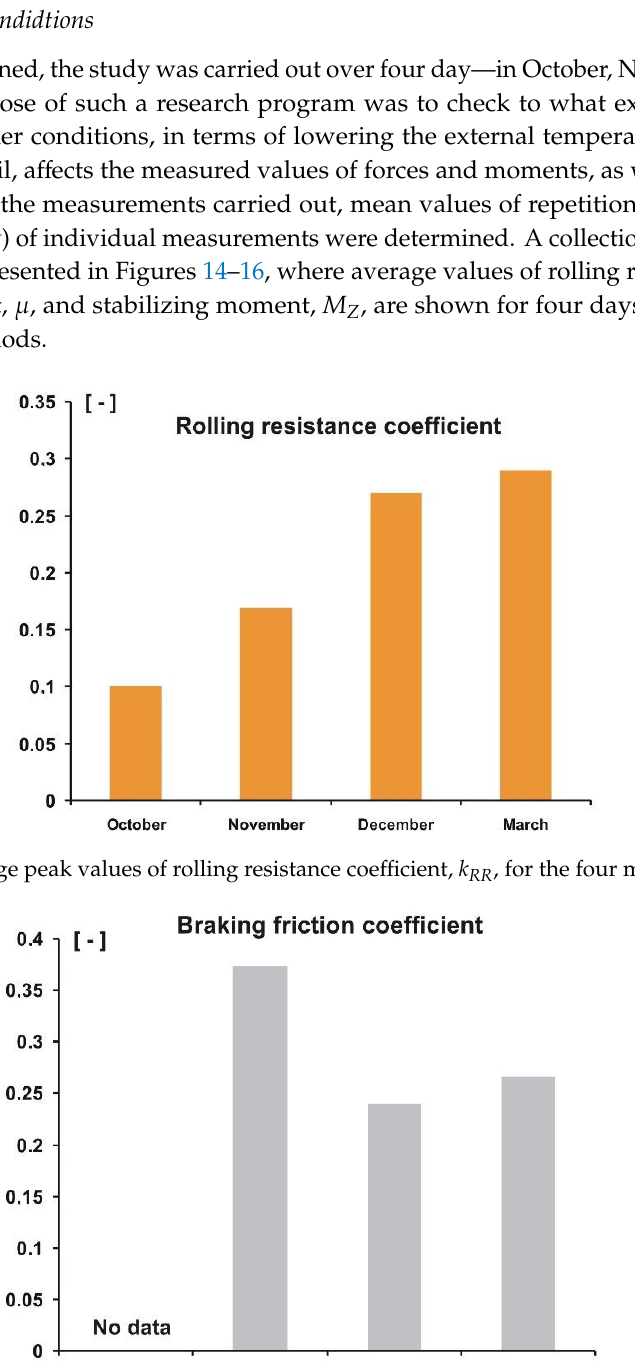
Figure 16. Average peak values of aligning moment, M Z , for the four measurements. 4. Conclusions An airfield experiment was conducted in order to measure landing gear wheel forces and moments. A five-element wheel force sensor was used to measure F X and F Z forces and M X , M Y , and M Z moments acting on an aircraft wheel during a low-speed taxiing. The measurement was conducted using the PZL 104 Wilga 35A as a test aircraft. The wheel force sensor was installed on the left landing gear in place of the wheel. Forces and moments were measured on a grassy surface of the Rzeszów Jasionka aerodrome, four times on days of autumn and spring months. The results show